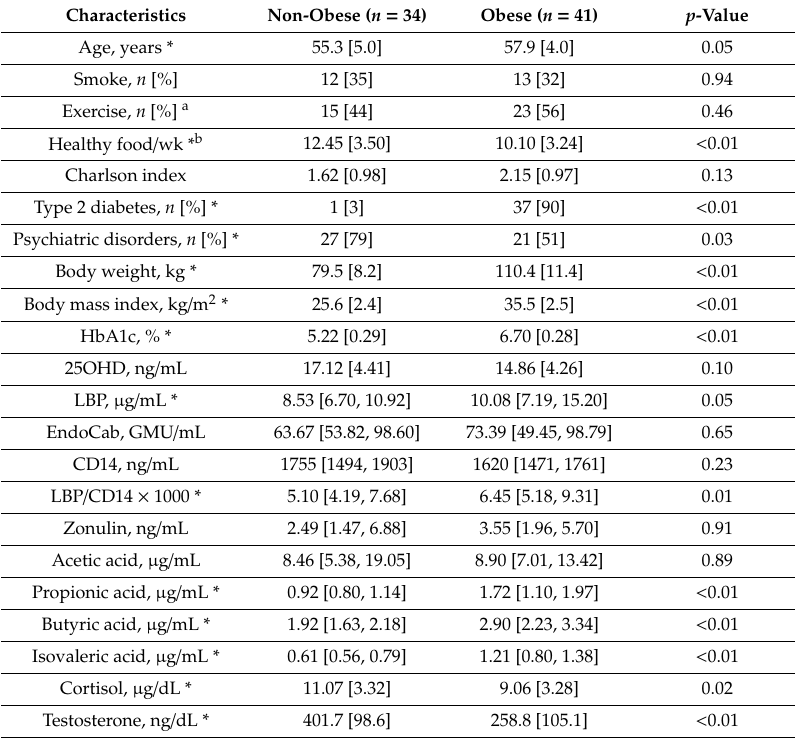
Table 1. Characteristics of non-obese and obese